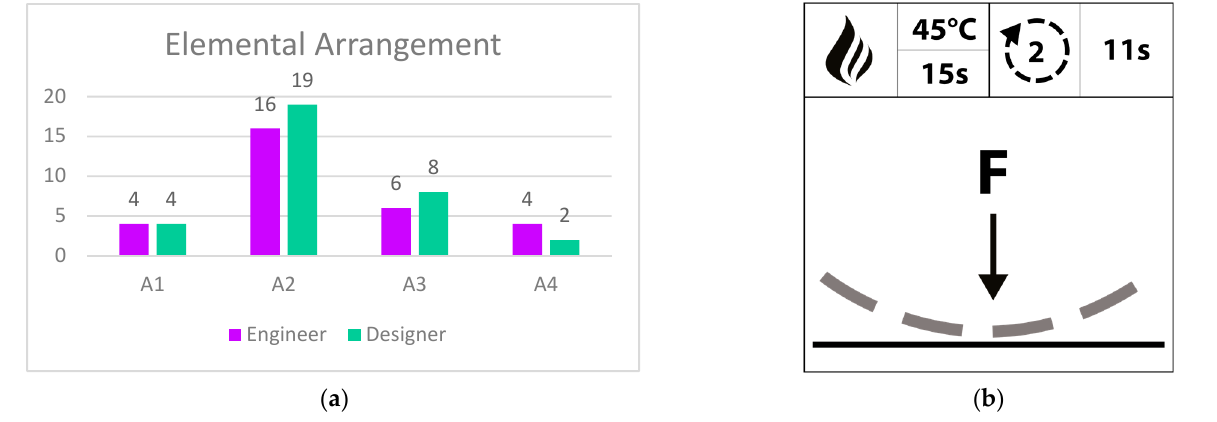
Figure 5. ( a ). Elemental task result ( b ). The most suitable arrangement.